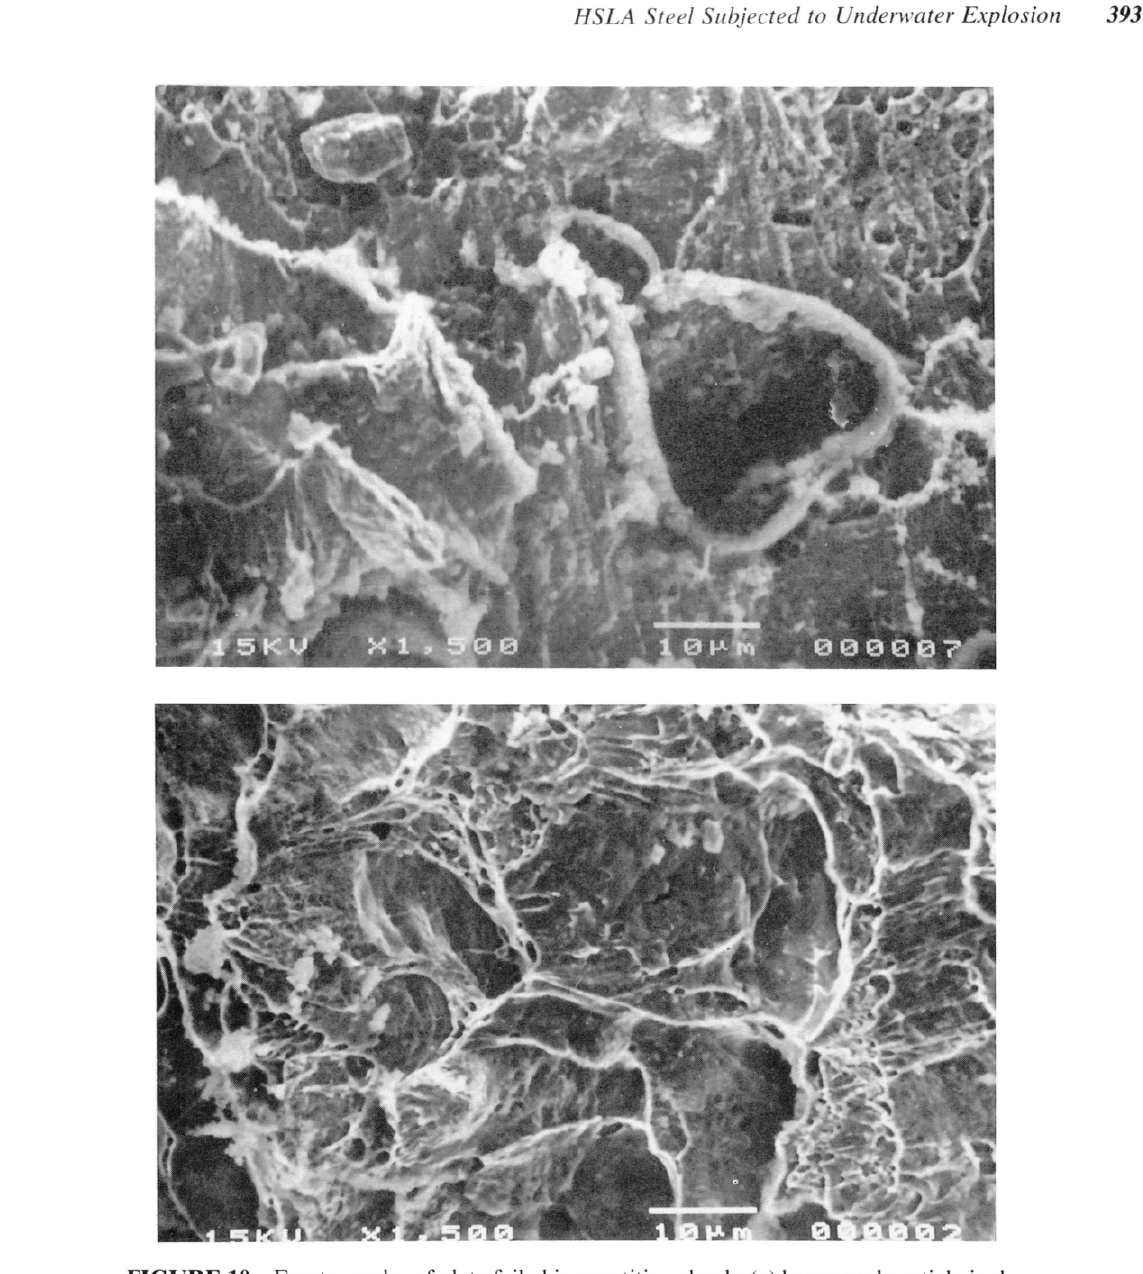
FIGURE 10 Fractography of plate failed in repetitive shock: (a) hexagonal particle inclu sion and initiation of microcrack from void and (b) dimple